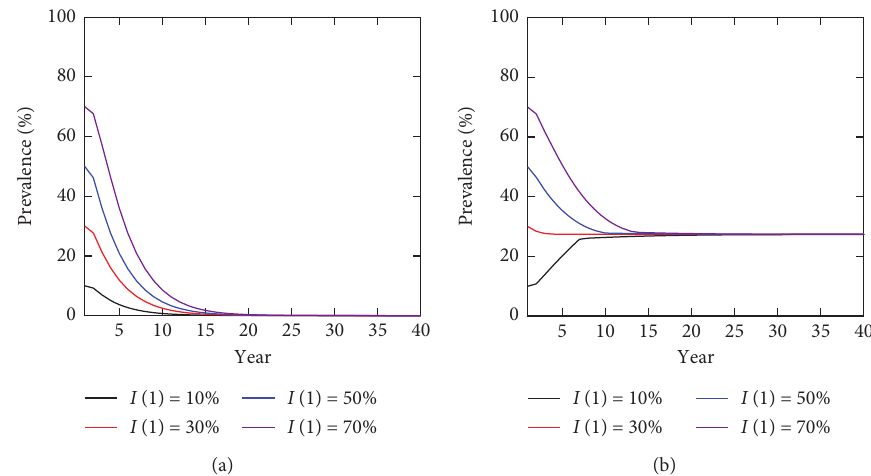
Figure 3: Global stability of disease-free and endemic equilibria. (a) Reproduction number R to 0.5 and all other parameters not specified are used according to Table 1. (b) Reproduction number R